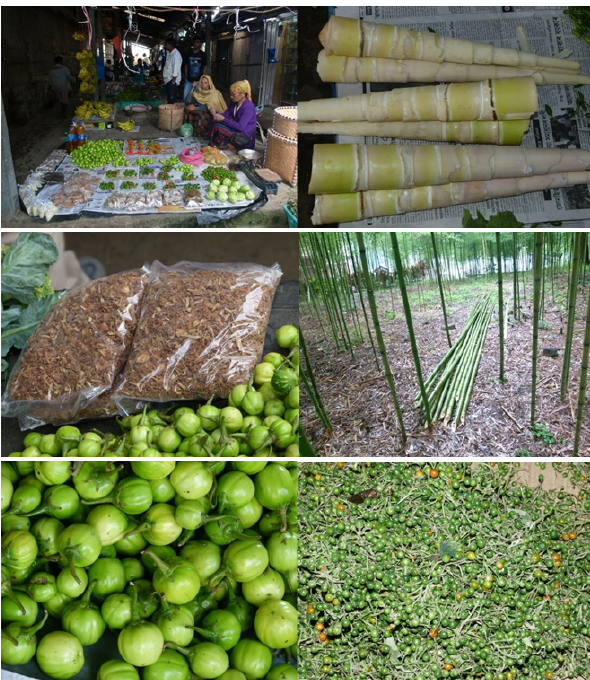
Fig. 7. Local NTFPs used by Apatani . Left to right: first row - Different products in daily market stall and Bamboo shoot; second row - Hiyi and Bije ; third row - Byako ( Solanum kurzii ) and Byako ami ( Solanum sp )